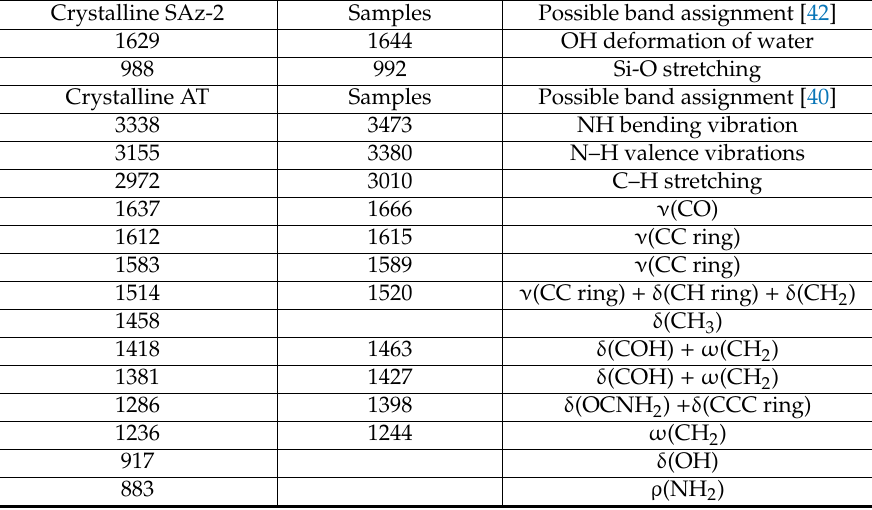
Crystalline AT Samples Table 2. FTIR band positions (cm − 1 ) for crystalline AT and SAz-2 after adsorption at pH 10.